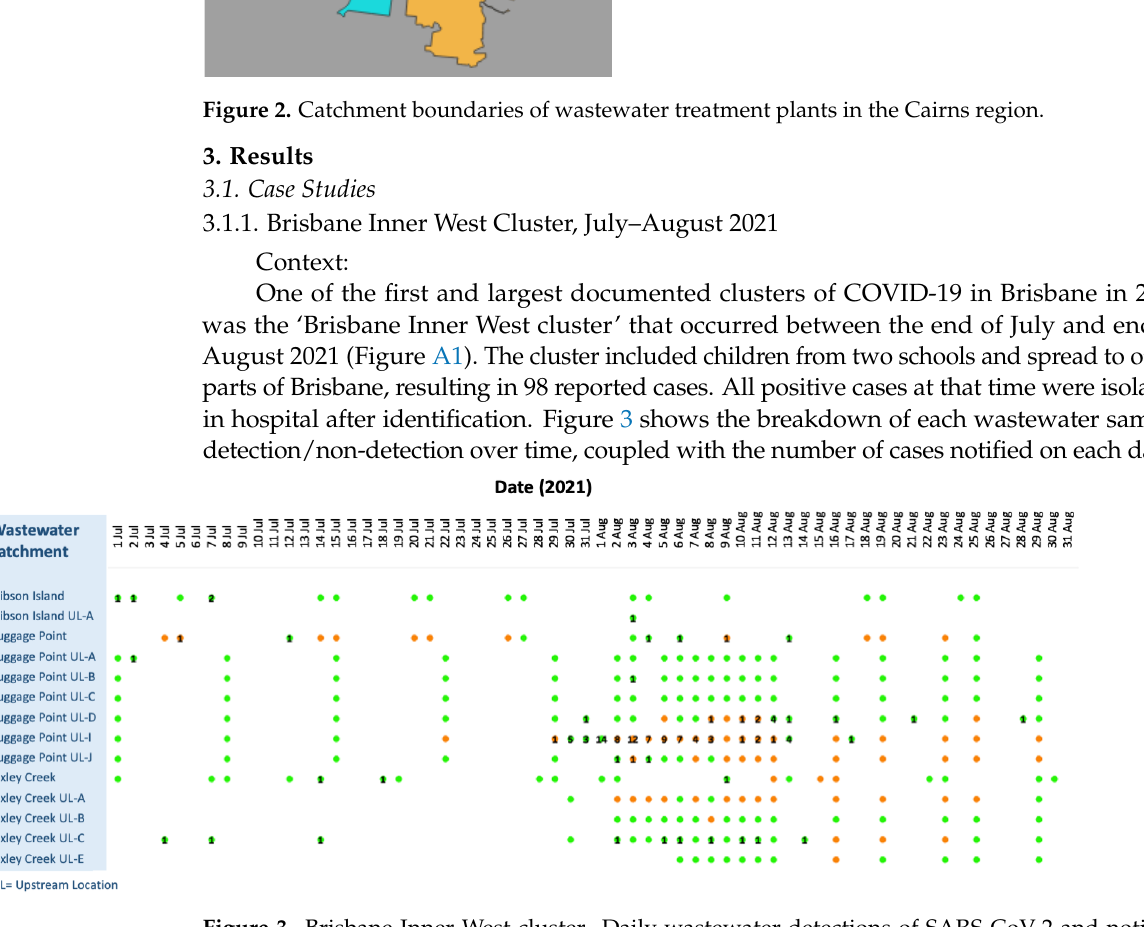
Figure 3. Brisbane Inner West cluster. Daily wastewater detections of SARS-CoV-2 and notified case numbers of COVID-19 across the Luggage Point, Oxley Creek, and Gibson Island wastewater treatment plants and upstream sampling sites from 1 July to 30 August 2021. Orange = posi- tive wastewater detections, green = wastewater samples collected but SARS-CoV-2 not detected. Numbers = reported cases in each